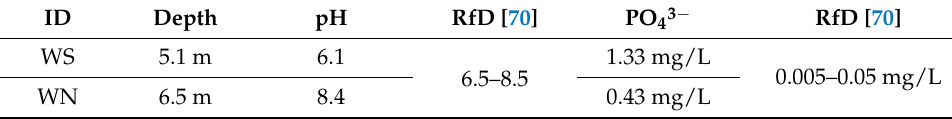
Table 4. Data validation of electrical resistivity and modified DRASTIC. ID